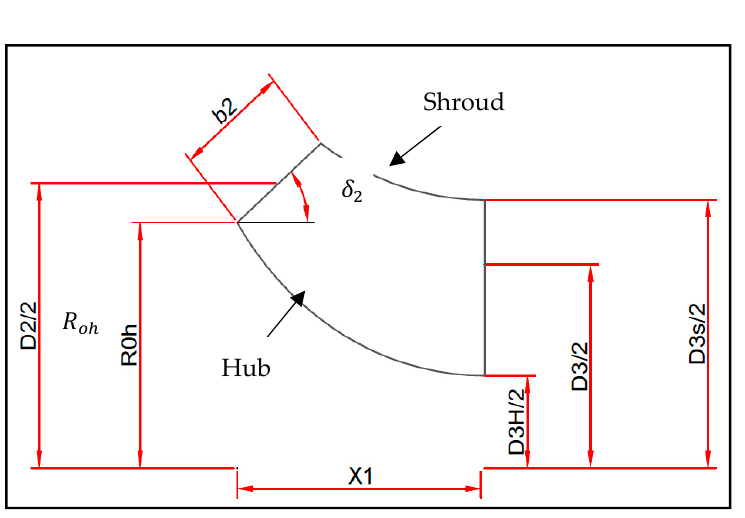
Figure 1. The blade Meridian view [42].